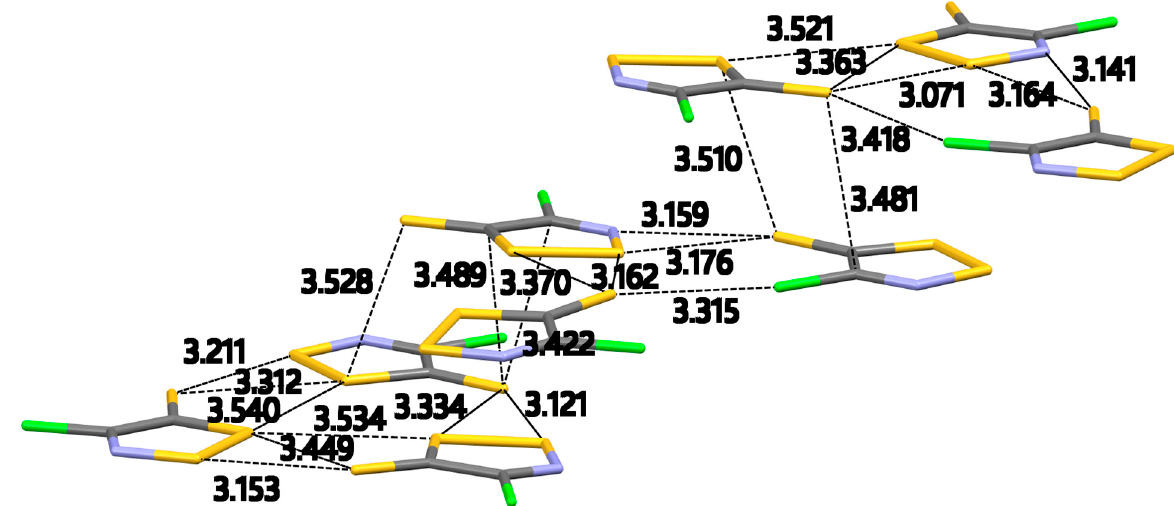
Figure 3. Intermolecular short contacts (Å) for the three supramolecular triangles of dithiazolethione 2c– β formed by the six molecules in the asymmetric unit cell.